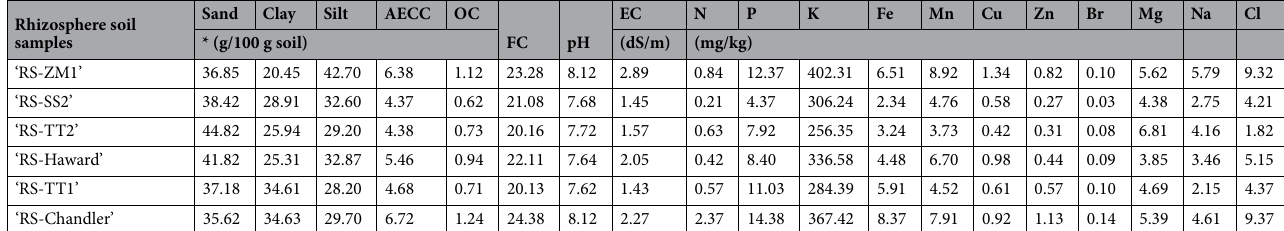
Table 1. Physio-chemical characteristics and mineral elements of soils from the different rhizospheres of walnut trees. AECC active equivalent calcium carbonate, OC organic carbon, FC field capacity, pH acidity of soil, EC electrical conductivity. *Each measurement is the mean of three replications. All of the nutrients were measured as the absorbable